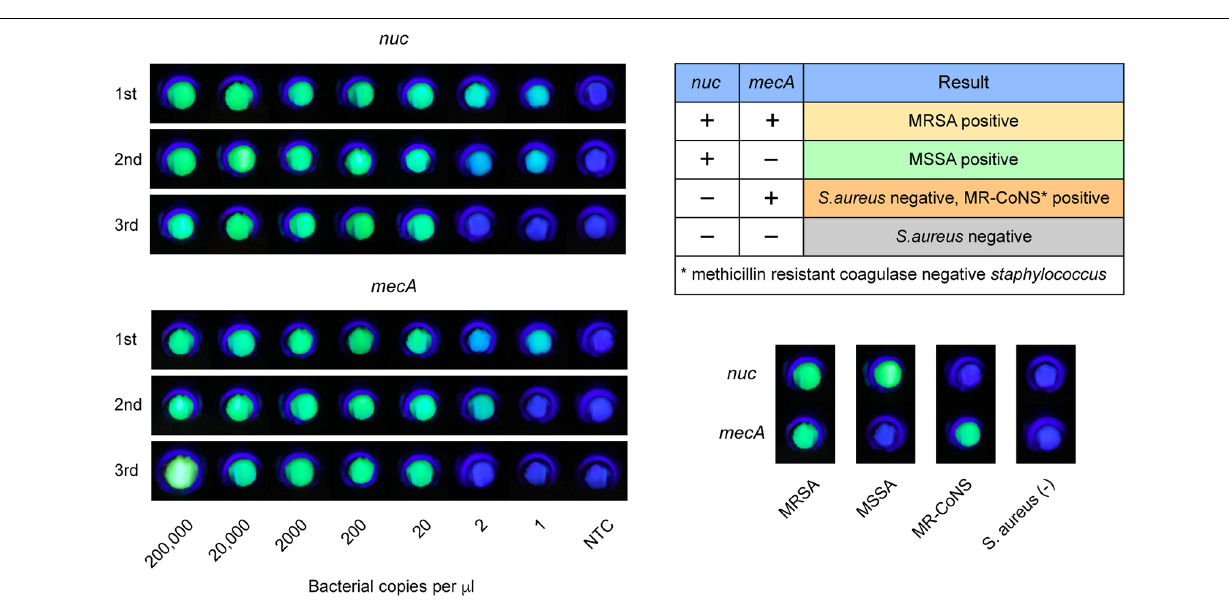
cleavage activity of the Cas12a effector. The cleaved ssDNA reporters produced fluorescent signals, which could be seen through a portable fluorescence reader ( Figure 2 ). The entire